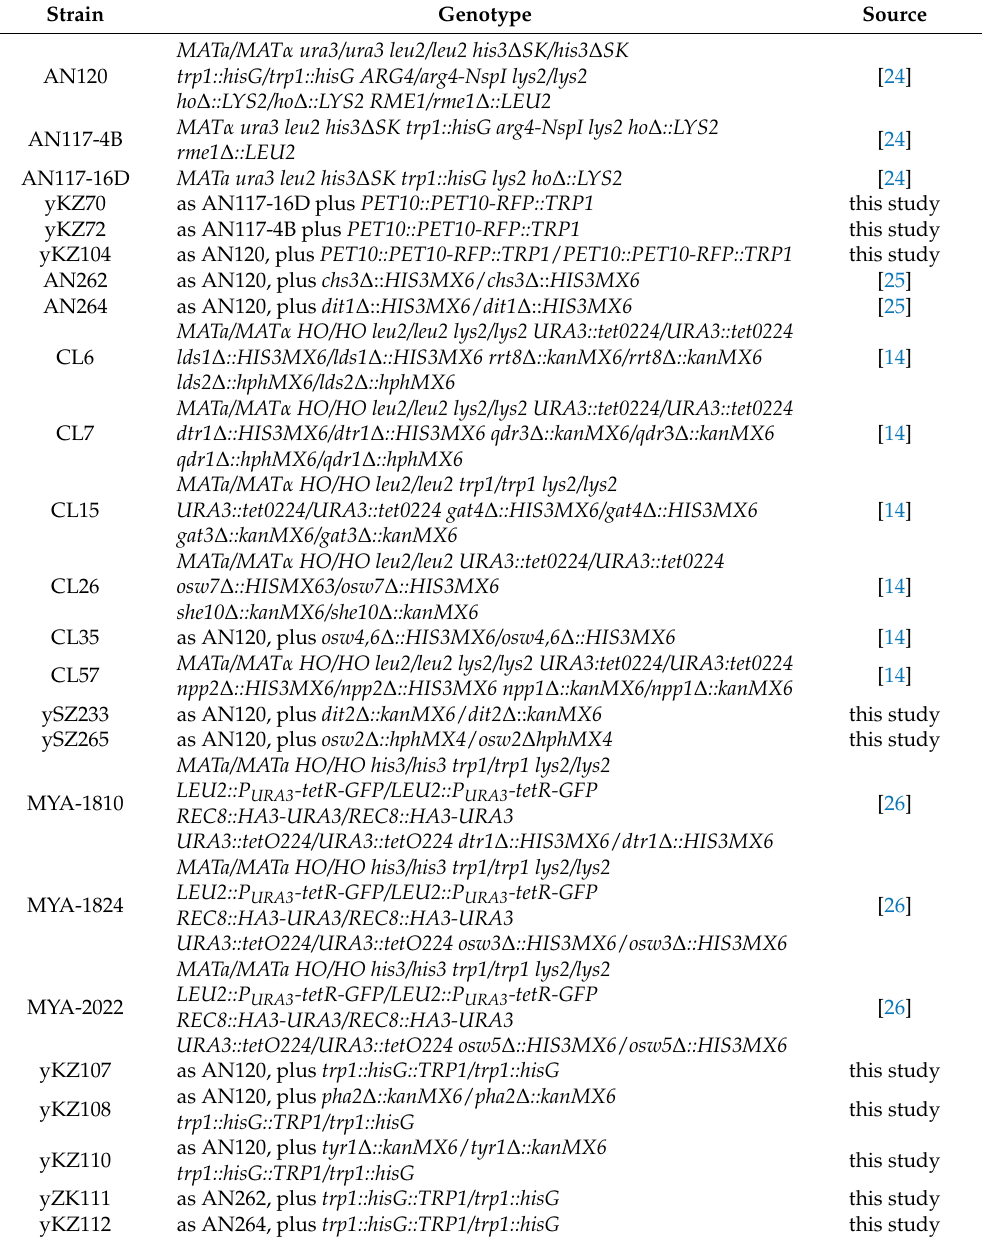
Table 1. Strains used in this